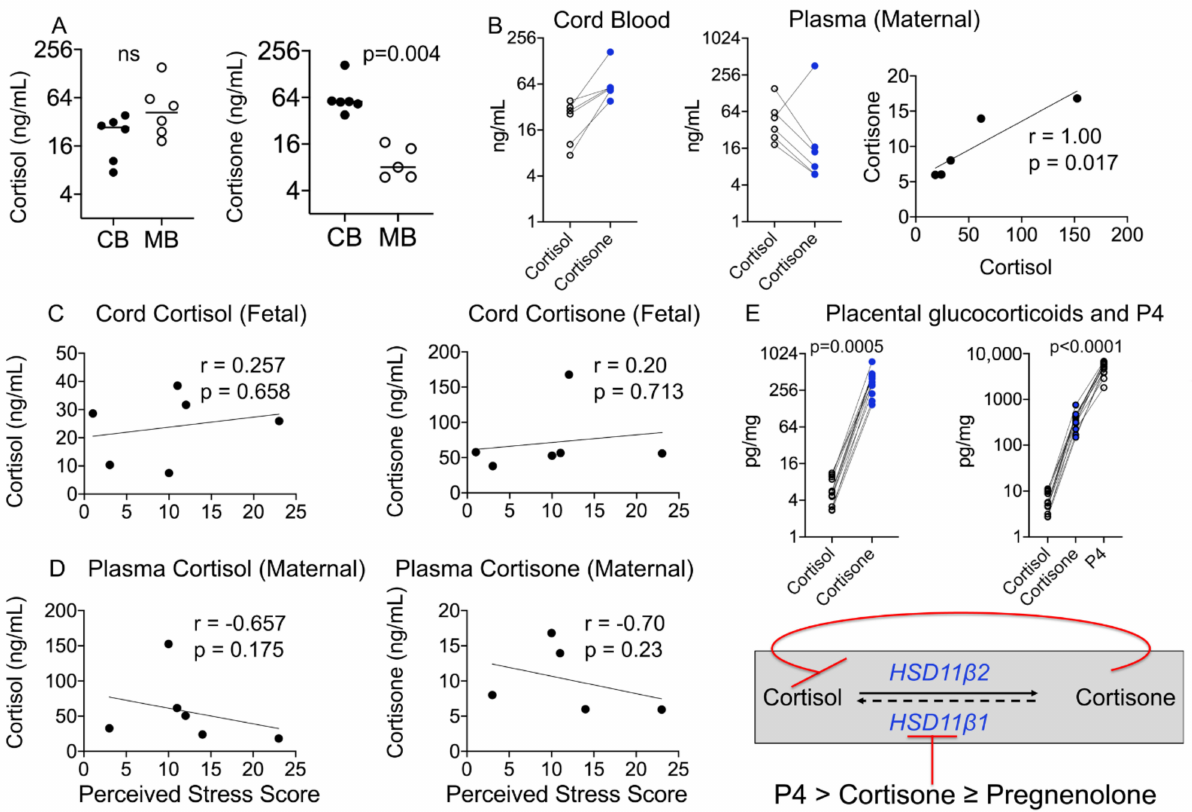
Figure 2. Maternal–fetal glucocorticoid metabolite levels and correlation with birth outcomes and the PSS. ( A ) Maternal–fetal cortisol levels did not differ significantly, but cord cortisone levels were significantly higher than maternal levels ( p = 0.004). ( B ) Individual cord cortisone levels were higher than cortisol levels, whereas maternal cortisone levels were lower than cortisol levels in all individuals except one. Maternal plasma cortisol correlated positively with maternal plasma cortisone ( r = 1.00, p = 0.017). ( C ) Fetal cortisol or cortisone and ( D ) maternal cortisol or cortisone did not correlate with the PSS. N = 6. ( E ) Fetal cortisone levels are maintained high as placental cortisone and progesterone inhibit the activity of HSD11 β 1; individual placental cortisone levels were higher than placental cortisol levels ( p = 0.005) and progesterone (P4) levels were ~13-fold higher than cortisone levels ( p < 0.0001). N = 17. Mann–Whitney U test and Spearman’s correlation